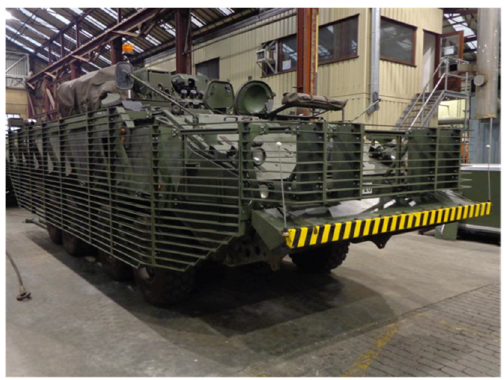
Figure 6. Slat armour system mounted on a Belgian engineering vehicle (Piranha AIV).